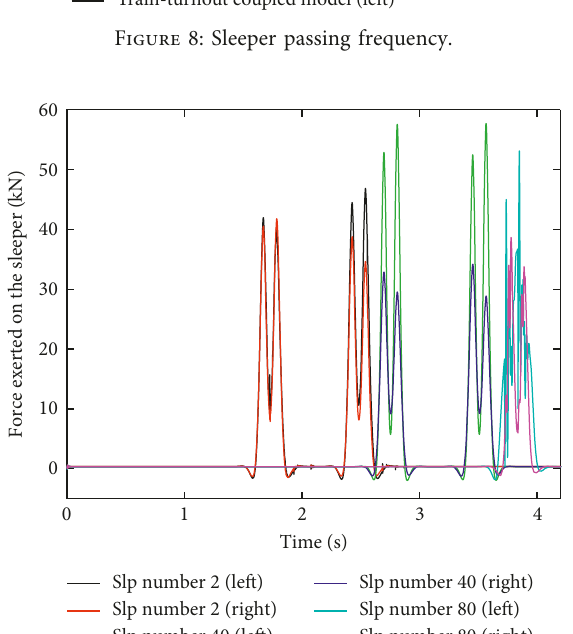
Figure 8: Sleeper passing frequency.